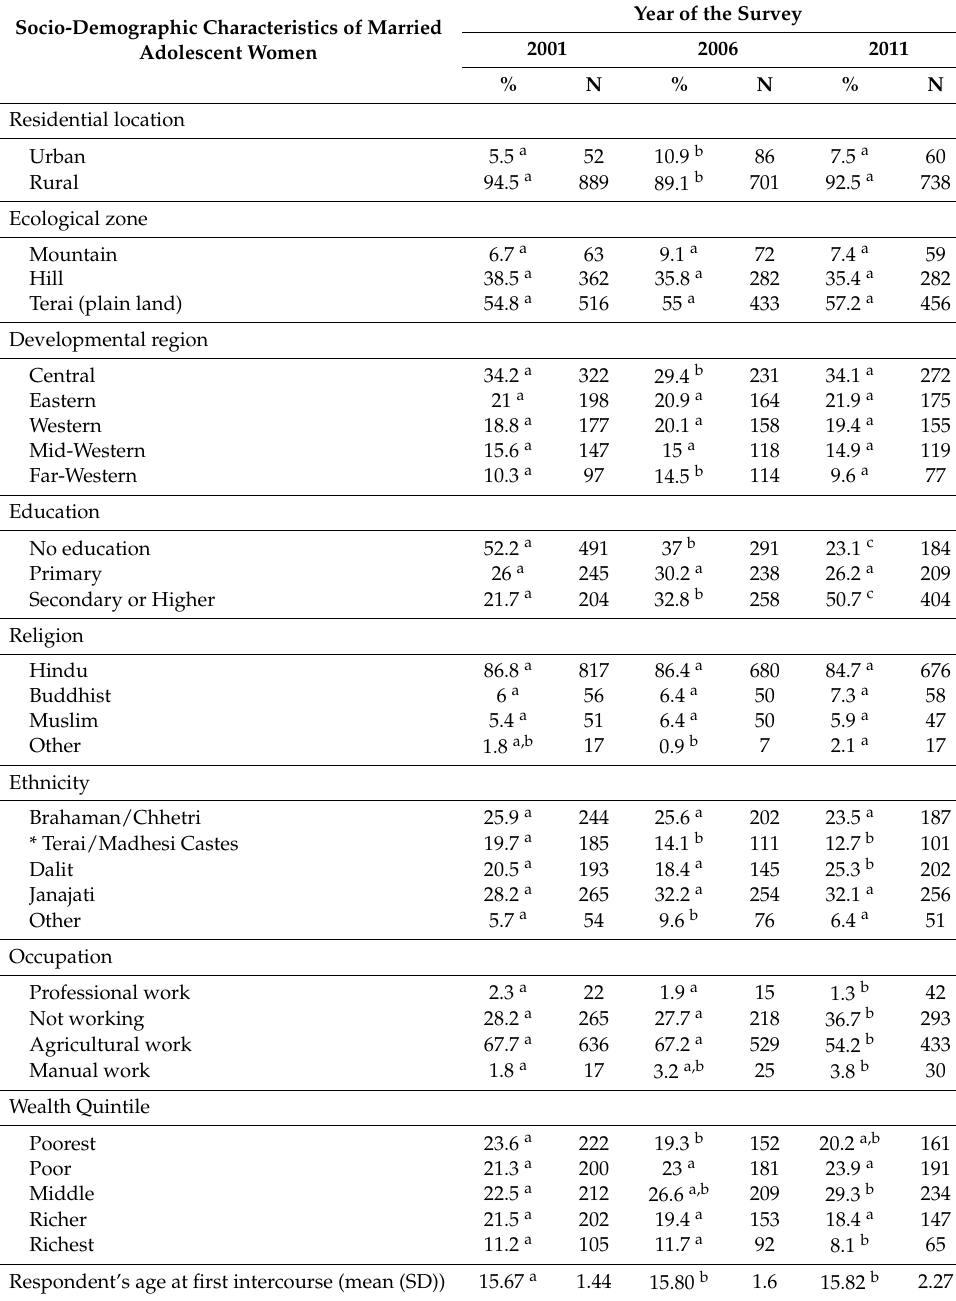
Table 2. Socio-demographic characteristics of married adolescent women and their husbands for each study year. Socio-Demographic Characteristics of Married Adolescent